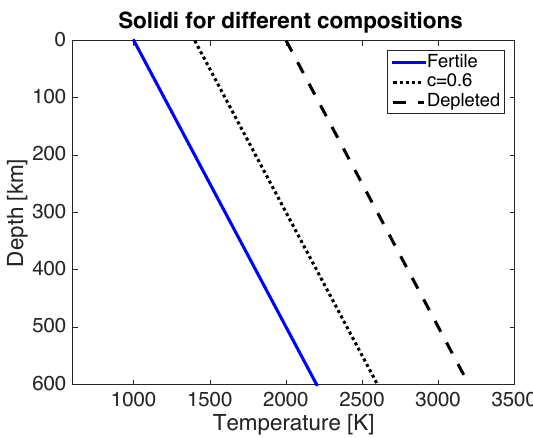
Figure 2. Composition-dependent solidi. The slope of the solidi used is 2Kkm − 1 . The difference between the solidi for completely fertile and fully depleted material is 1000K. The solidus for the ini- tial value for bulk composition (0.6) is plotted as an